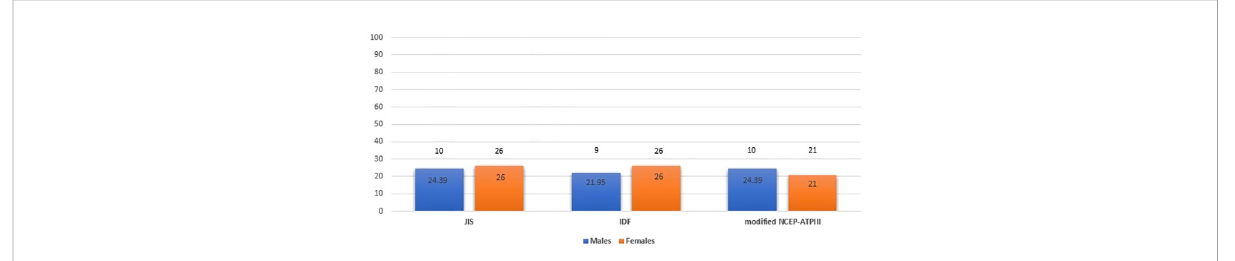
FIGURE 2 Metabolic syndrome prevalence in APS patients by sex (males and females) based on JIS, IDF and modi fi ed NCEP-ATPIII criteria (Percentages and absolute numbers are noted) APS, Antiphospholipid syndrome; JIS, Joint Interim Statement; IDF, International Diabetes Federation; NCEP- ATPIII, National Cholesterol Education Program Adult Treatment Panel